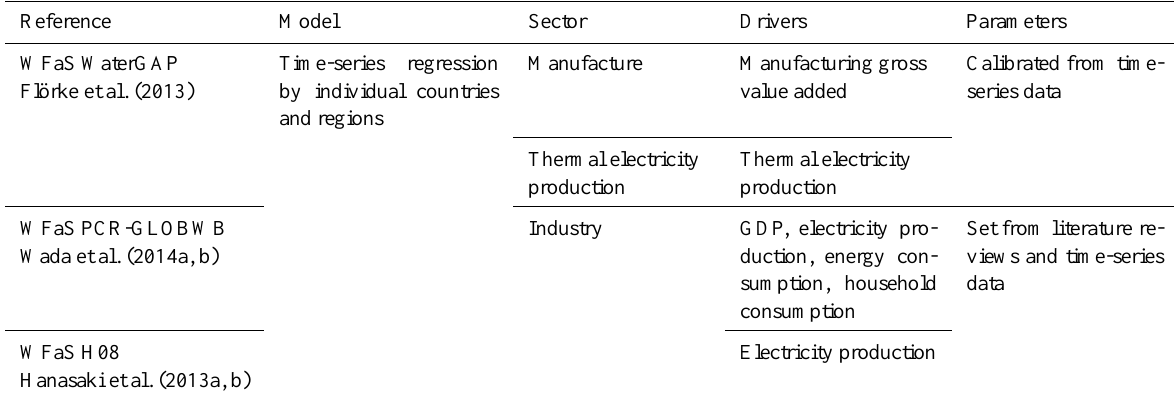
Table 2. Summary of industrial water withdrawal estimation models in this